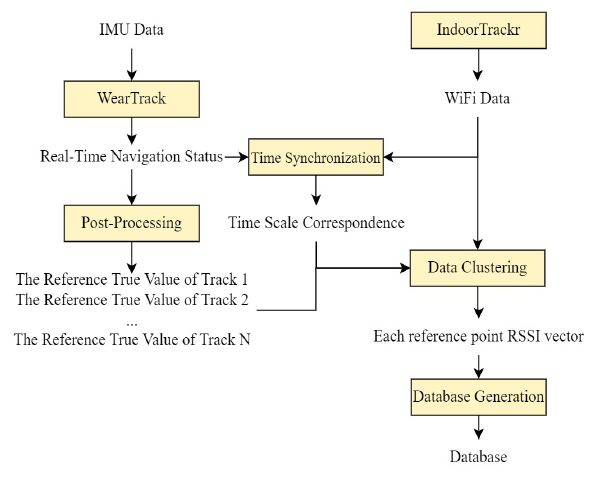
Figure 1 . Overall Technical Route